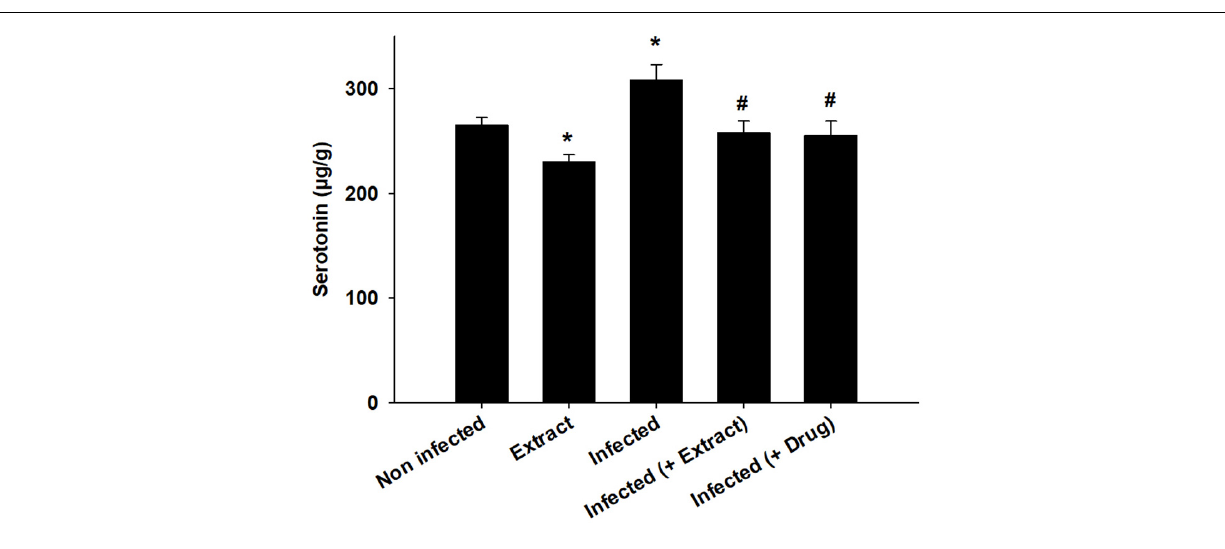
Frontiers in Microbiology |